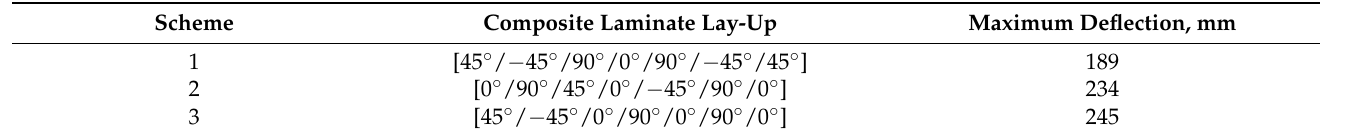
Table 4. Deflection of composite structure with various stacking sequence.